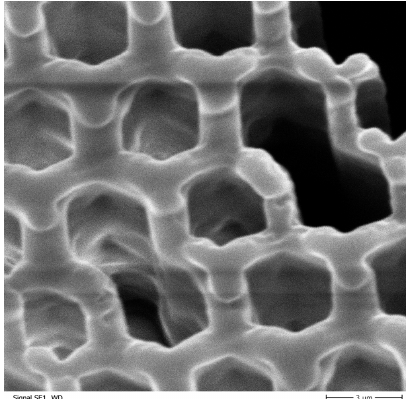
Figure 17. Quantity scale: hex structure: medium